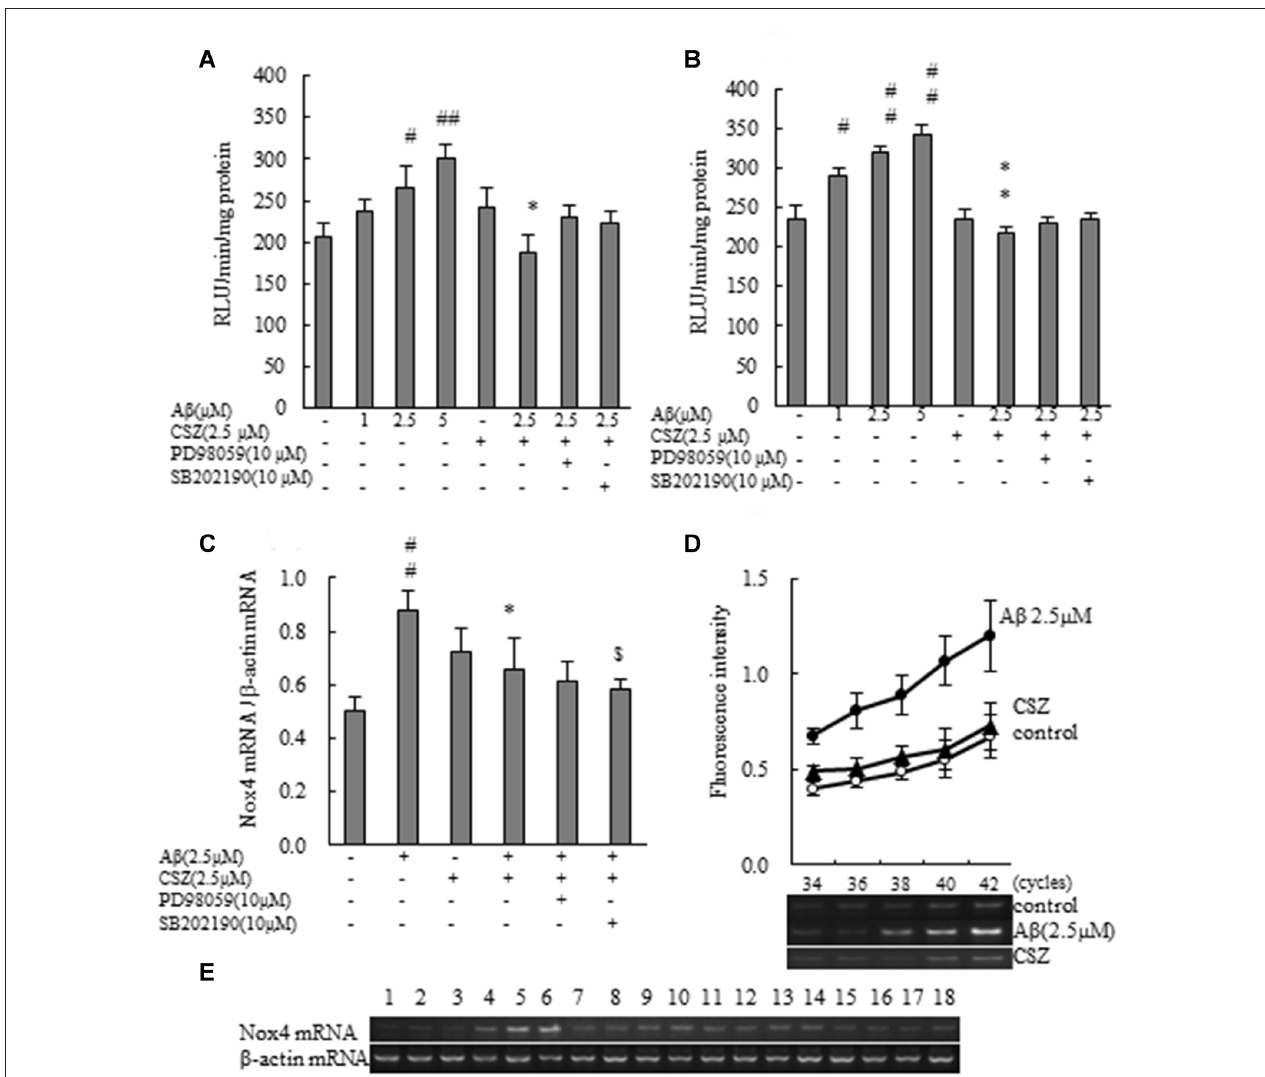
FIGURE 4 | Effect of CSZ on Nox activity and the mRNA expression analysis of NOX4 in A β -stimulated SH-SY5Y cells. (A) Nox activities were determined in SH-SY5Y cells incubated with or without 1 h pretreatment with CSZ or inhibitor of MEK1/2 or p38 MAPK followed by 1 h incubation with A β . Values are expressed as mean + SEM. (B) Nox activities were determined in SH-SY5Y cells incubated with or without 1 h pretreatment with CSZ or inhibitor of MEK1/2 or p38 MAPK followed by 20 h incubation with A β . Values are expressed as mean + SEM. (C) The mRNA expression analysis of NOX4 in treated SH-SY5Y cells are examined. The effects of respective inhibitor were also examined. Values are expressed as mean + SEM. (D) Reaction cycles-PCR product yield curves of each reaction mixture were plotted. (E) Picture shows the bands obtained in agarose gel electrophoresis for Nox4 and β -actin. Lane1–3: control, Lane4–6: 2.5 µ M A β , Lane7–9: 2.5 µ M CSZ, Lane10–12: 2.5 µ M A β + 2.5 µ M CSZ, Lane13–15: 2.5 µ M A β + 2.5 µ M CSZ + 10 µ M PD98059, Lane16–18: 2.5 µ M A β + 2.5 µ M CSZ + 10 µ M SB202190. # Compared vs. respective control cells ( p < 0.05). ## Compared vs. respective control cells ( p < 0.01). ∗ Compared vs. A β -treated cells ( p < 0.05). ∗∗ Compared